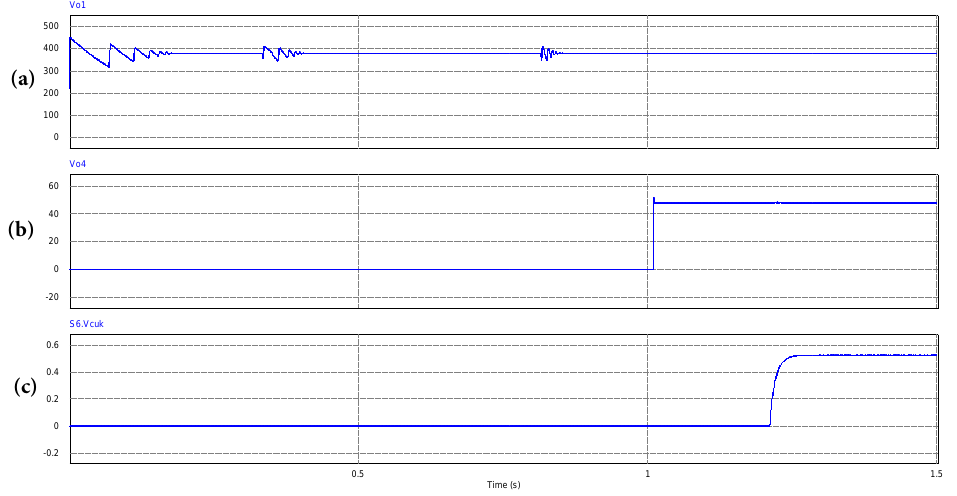
Figure 29. Third set of simulation results, ( a ) primary DC bus, ( b ) 1.2 kW converter output voltage and ( c ) terciary lighting bus. Waveforms are: Figure 29a, primary bus voltage; and Figure 29b, 1.2 kW converter output voltage are used like time refrences; Figure 29c represents a tertiary lighting bus enabled at 1 s by 400 W converter, well regulated 48 V bus can be seen despite connection/disconnection of tandem driver Cuk-LED luminaries. The furthest functional trajectory for DCMG is from boost converter to lighting tandem driver-luminary, Figure 30 shows this power path.